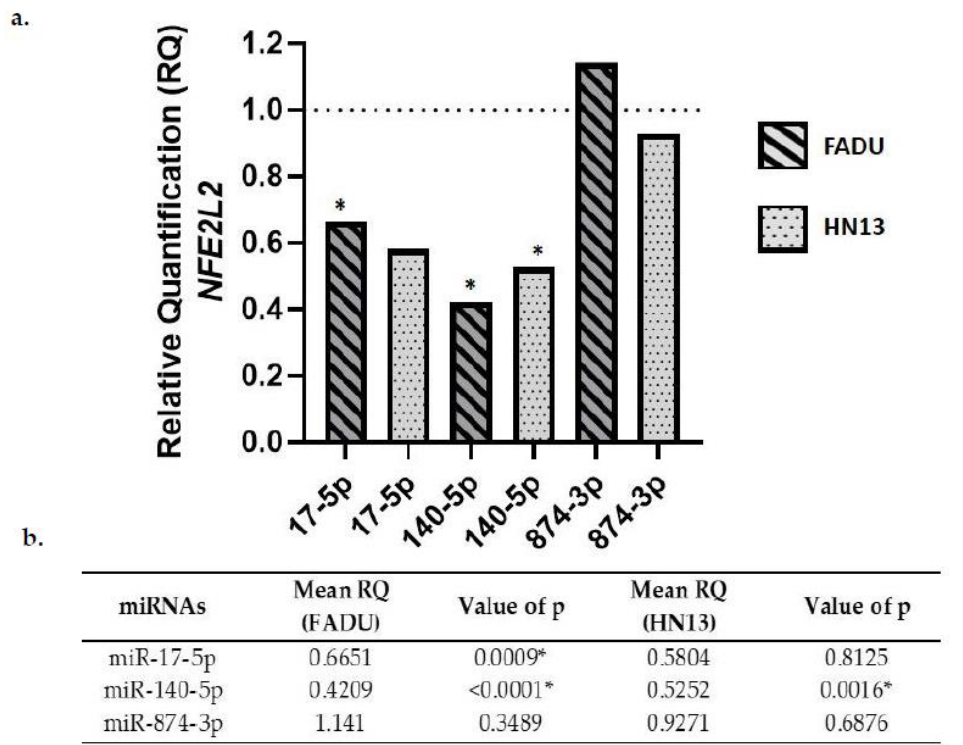
Figure 4. ( a ) NFE2L2 gene expression after miR-17-5p, miR-140-5p, and miR-874-3p transfection compared to the negative control (RQ = 1). ( b ) Relative quantification mean (RQ) of NFE2L2 gene expression in HNC cell lines transfected with miR-17-5p, miR-140-5p, and miR-874-3p. * Significant